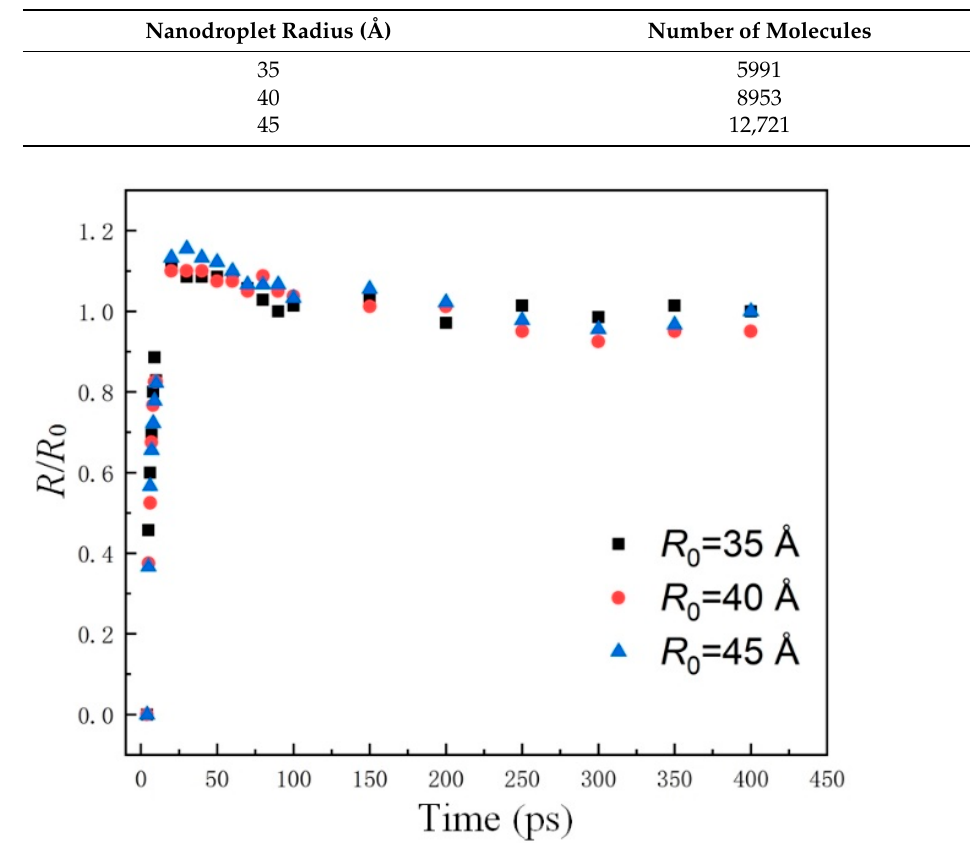
Figure 3. Effects of droplets size on spreading time.